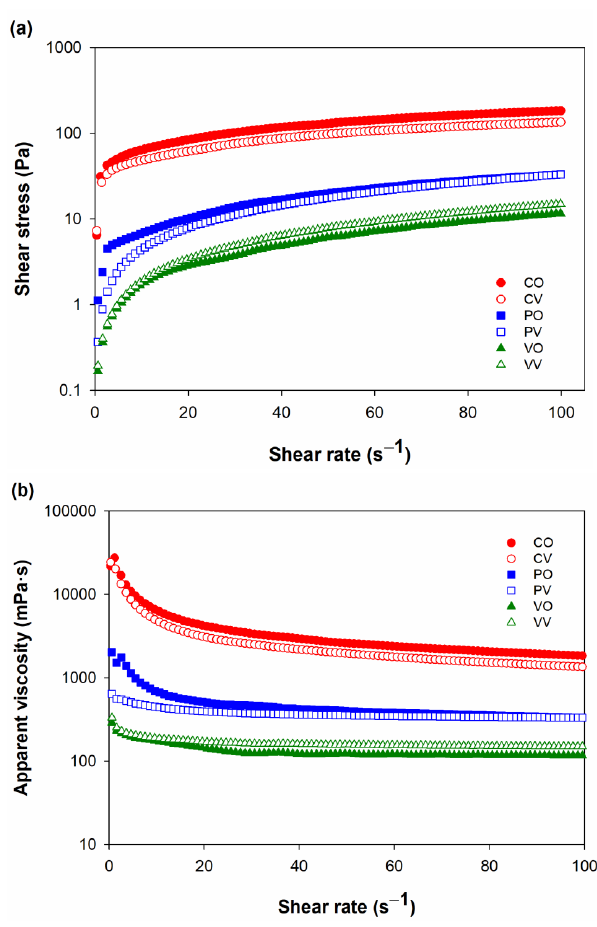
Figure 3. Relationship between shear rate and ( a ) shear stress and ( b ) viscosity measured at 25 °C of date syrups prepared from juice extracted without enzyme ( , ) and with the aid of Pectinex ( , ) or Viscozyme ( , ) followed by evaporation using open heating ( , , ) or vacuum evaporation ( , , ). Table 2. Rheological properties of date syrups prepared using different extraction and evaporation methods.